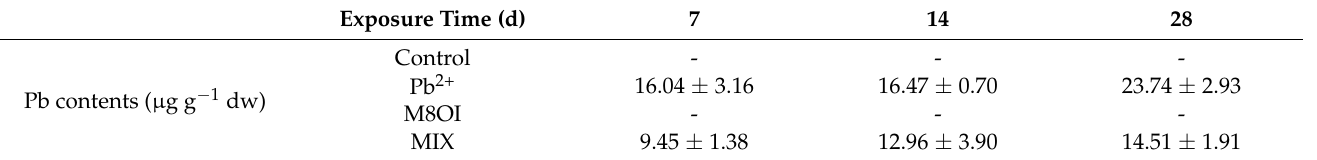
Table 1. The alteration of Pb bioaccumulation in fish brains associated with exposure time. Exposure Time